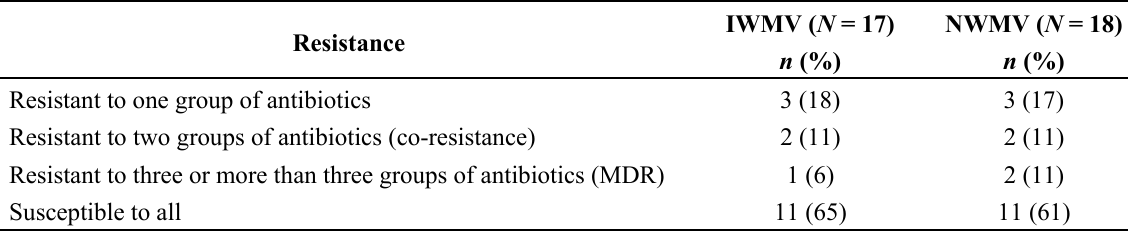
Table 4. Co-resistance and Multi Drug Resistance (MDR) of Escherichia coli from well water of tribal villages with and without the implementation of integrated watershed management